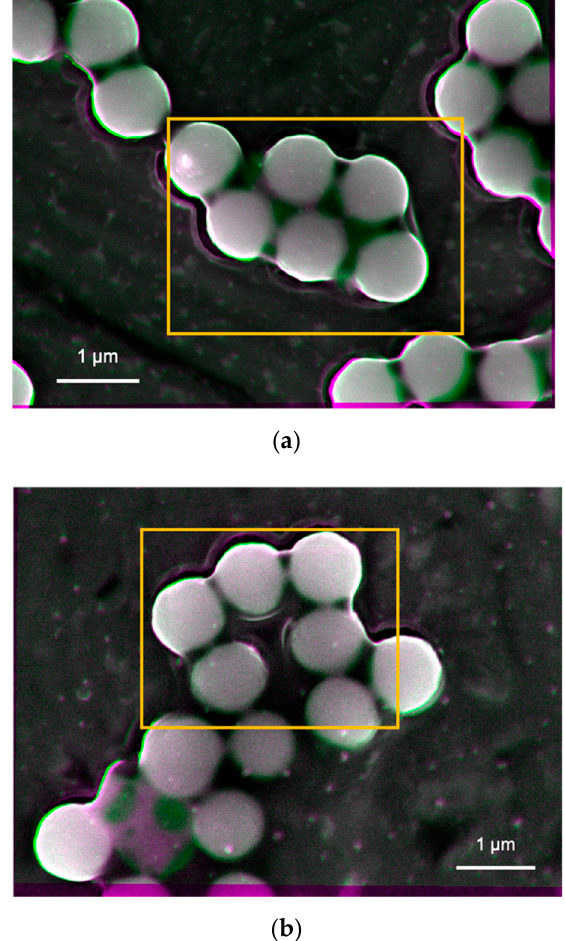
Figure 5. Processed images of the nanoparticle–substrate interfaces after subtracting two images taken at the acceleration voltages of 8.5 and 8.1 keV on the Tug 3 sample with different areas (a) and (b).